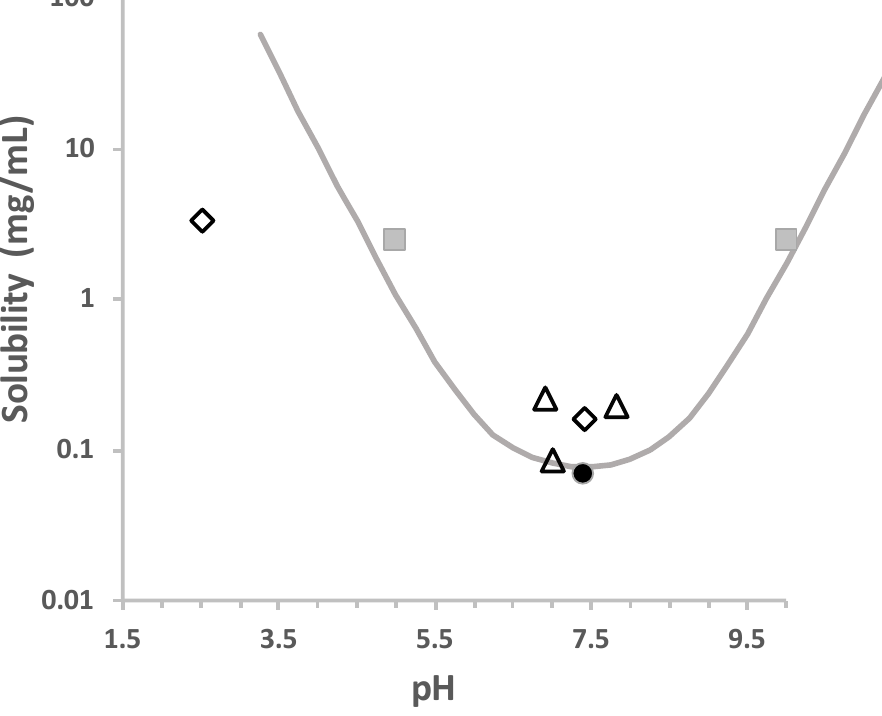
Figure 3. Effect of pH on CIP aqueous solubility calculated using the following equation: S = S 0 1 + 10 ( pka 1 − pH ) + 10 ( pH − pka 2 ) , with pka 1 = 6.2, pka 2 = 8.6 [20,75]. Individual values are from Yu et al. [76] (empty triangles); McShane et al. [20] (plain dot); Blokhina et al. [77] (empty diamond; Roca Jalil et al. [78] (square). Values were measured between 25 and 30 °C.